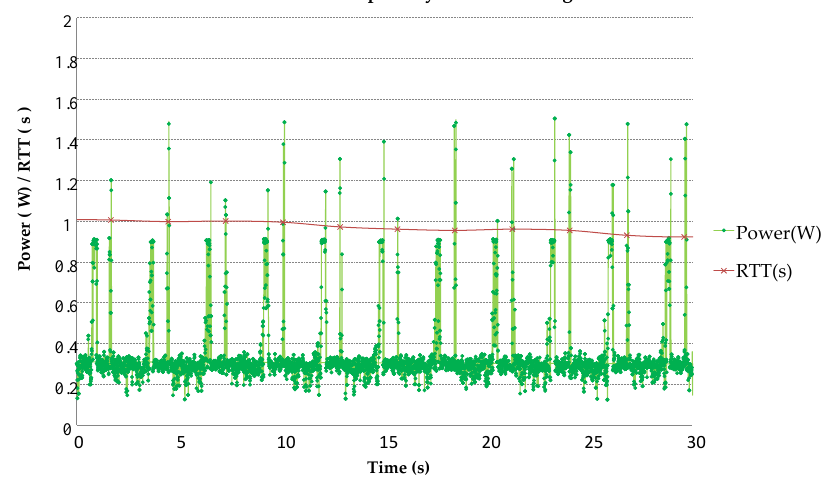
Figure 11. Power and round trip time in robust scenarios.